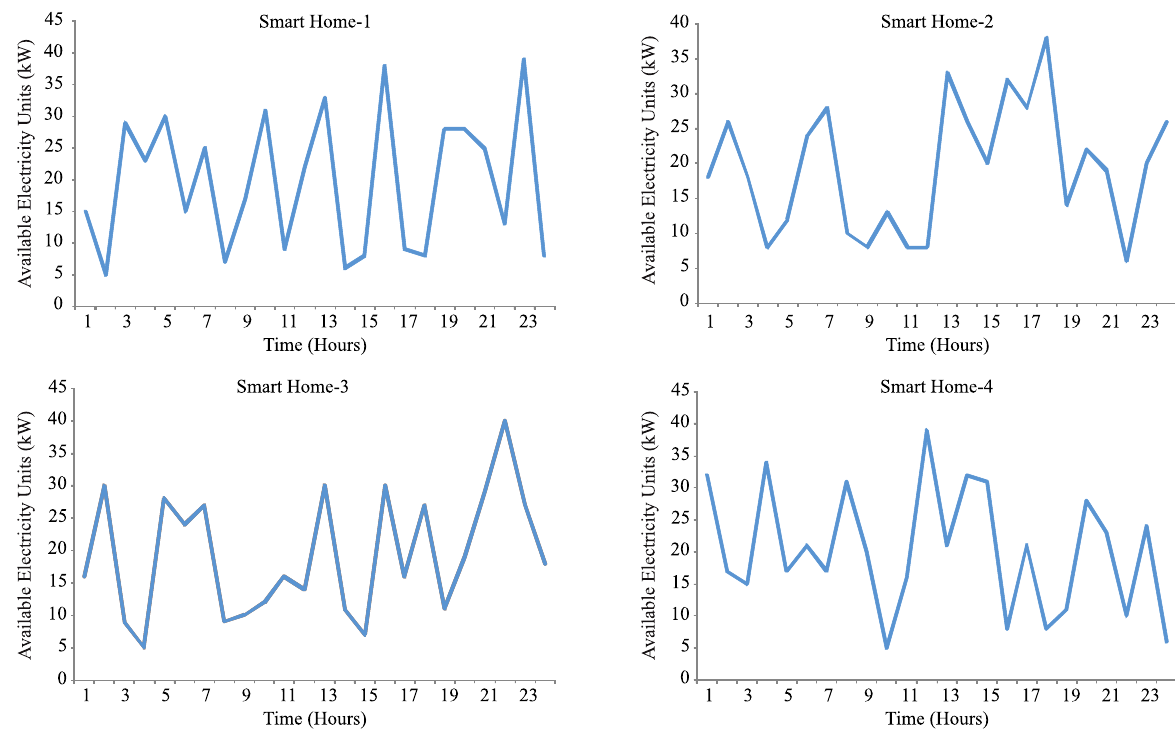
FIG. 4. AVAILABLE UNITS OF ELECTRICITY IN FOUR DIFFERENT SMART HOMES’ IN-HOUSE MINI